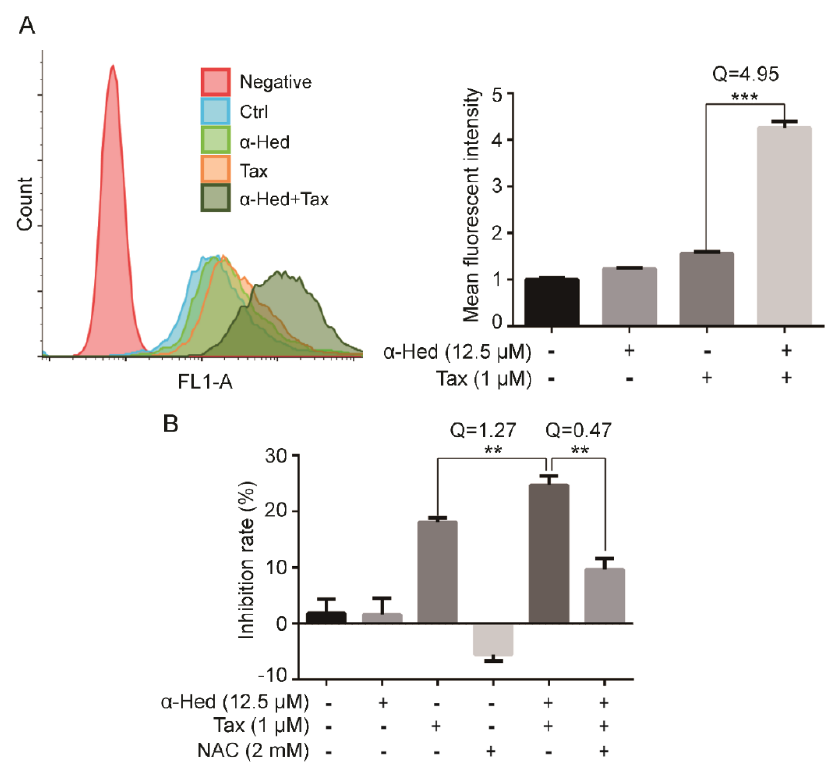
Figure 6. α -Hed sensitized cells to Tax-induced cell death via excessive reactive oxygen species (ROS) accumulation. ( A ) α -Hed pretreatment significantly increased ROS accumulation. *** p < 0.001. Q value > 1.15 indicated a synergistic effect. ( B ) N-acetylcysteine (NAC) reversed Tax-induced inhibition of cell proliferation. Cells were treated with or without α -Hed or Tax; 24 h later, the survival rate was detected using CCK-8. ** p < 0.01, *** p < 0.001. Q value > 1.15 indicates a synergistic effect; Q value < 0.85 indicates an antagonistic effect.